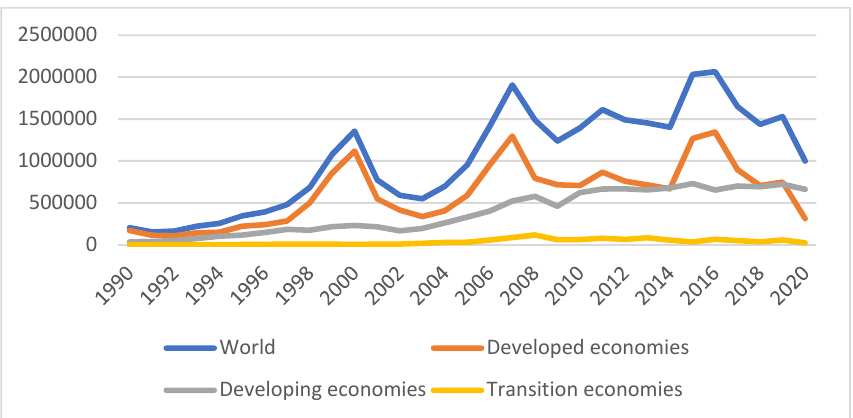
Figure 1. Development of inward FDI flows by groups of countries in millions of USD (own processing based on data from [42]).